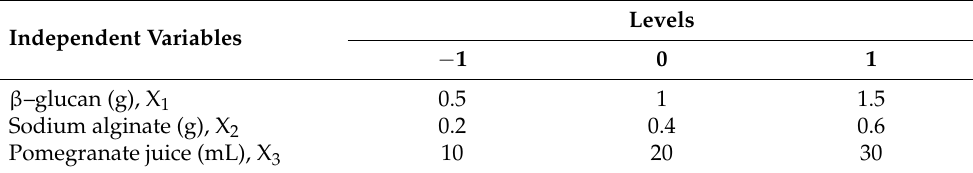
Table 1. Coded and uncoded values of processing variables. Independent Variables